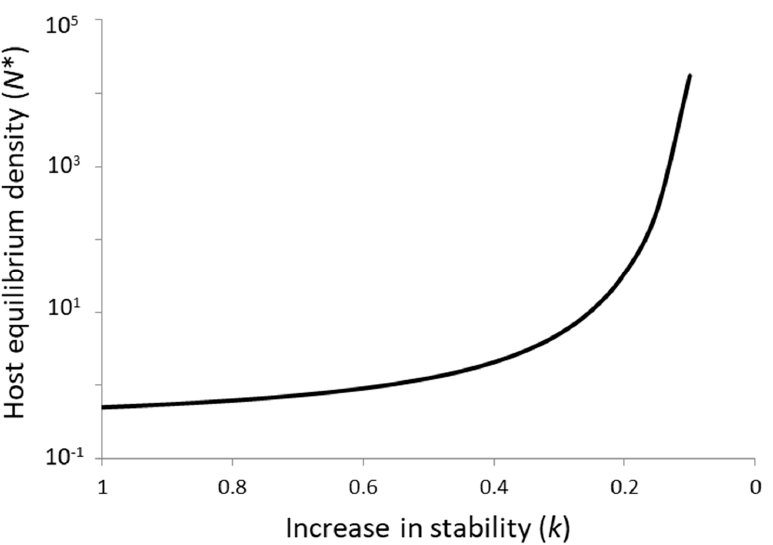
Figure 1. The paradox of biological control as illustrated by the Getz–Mills model [20], a discrete-time parasitoid–host model with aggregated (and host-density-independent) encounters between parasitoids and hosts and an attack strategy that varies from search limitation to egg limitation. The paradox is represented by the tradeoff between increased stability (greater aggregation of encounters, k → 0) and host equilibrium density ( N *).